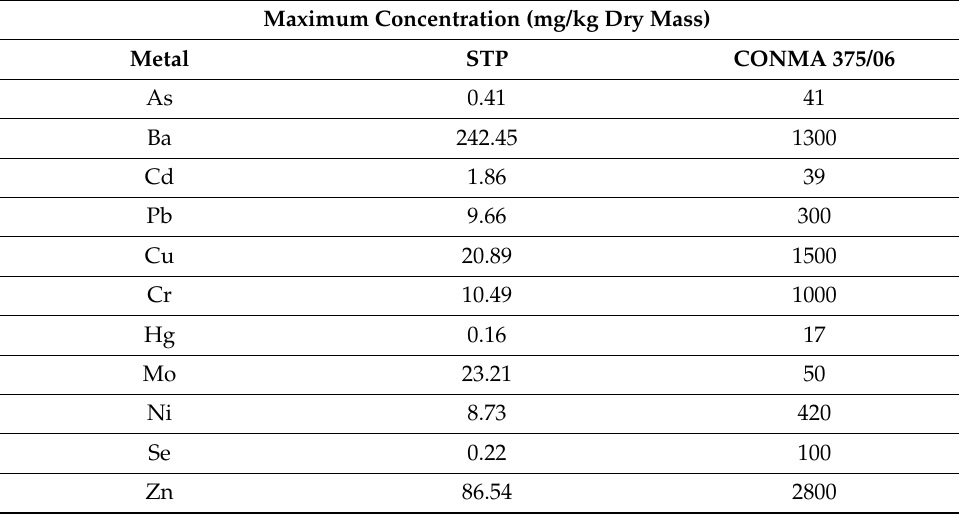
Table 1. Metal contents present in the sewage sludge